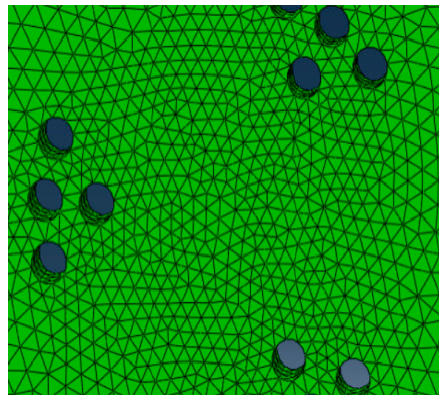
Figure 4. Detailed subdivision of the mesh.